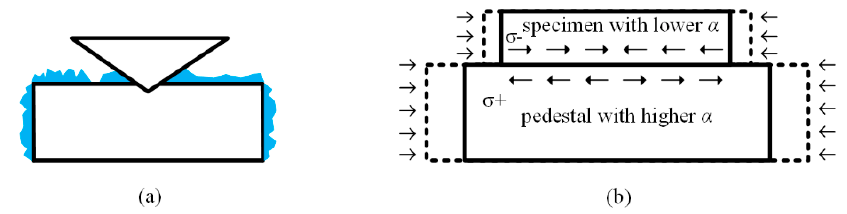
Figure 15. Possible influences occurred on specimen ( a ) ice on the surface ( b ) internal stress.